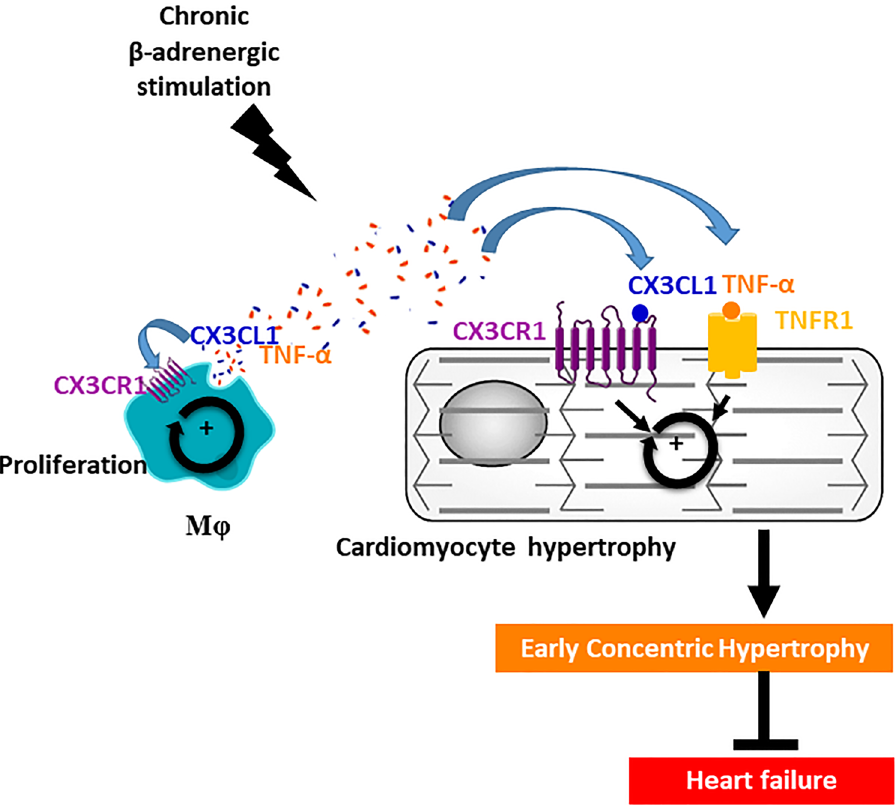
β-adrenergic stimulation activates the cardiac CX3CL1/CX3CR1 axis that supports early transient concentric remodeling and delays evolution towards heart failure: this is associated with a CX3CL1/CX3CR1-dependent expansion of cardiac Mφ. CX3CL1 and TNF-α secreted by cardiac Mφ synergistically trigger cardiomyocyte